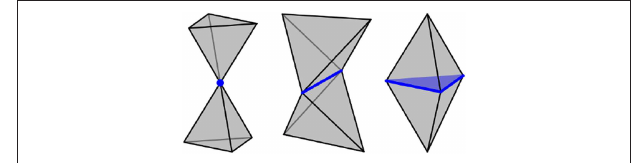
FIGURE 2 | Two tetrahedra could intersect not at all, on a 0-polytope (Left) , on a 1-polytope (center), or on a 2-polytope (Right) , corresponding to corner sharing, edge sharing and face sharing.